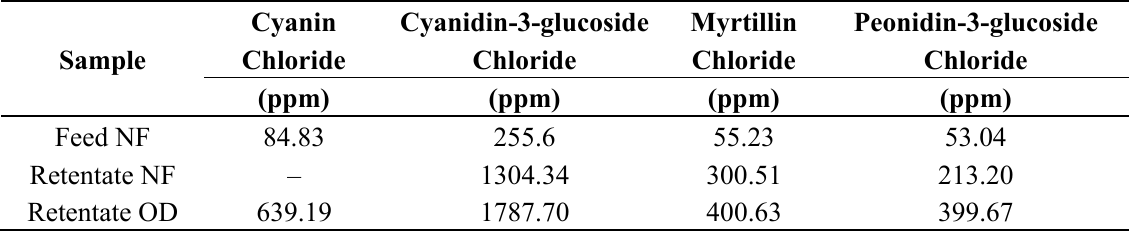
Table 6. Analytical evaluations of individual anthocyanins in samples of clarified liquor from NF-OD treatments.